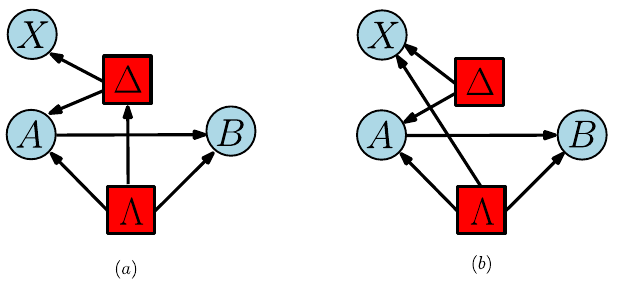
Figure 2: Causal graphs describing a noncausal instrumental variable, where the correlations between X and A are mediated by another latent factor Δ and its relaxations. ( a ) Relaxation of the independence assumption where Λ has some causal in fl uence over Δ . ( b ) The independence assumption is relaxed by a direct in fl uence of Λ over